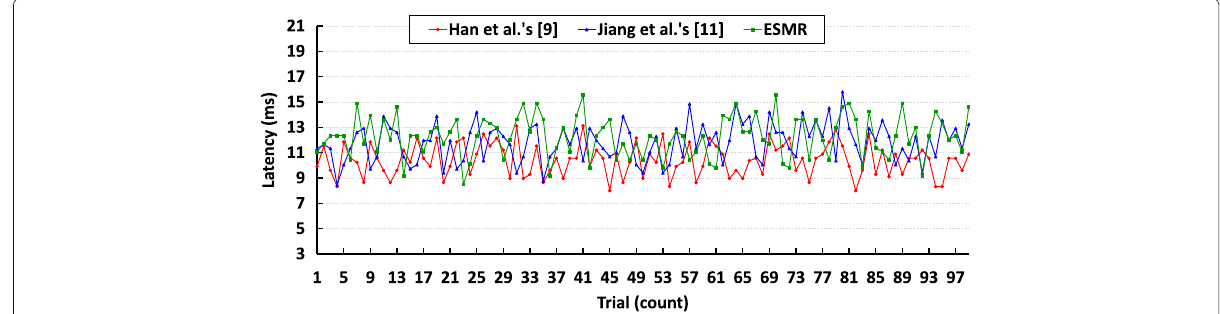
Fig. 7 Reauthentication latency when number of hops n =